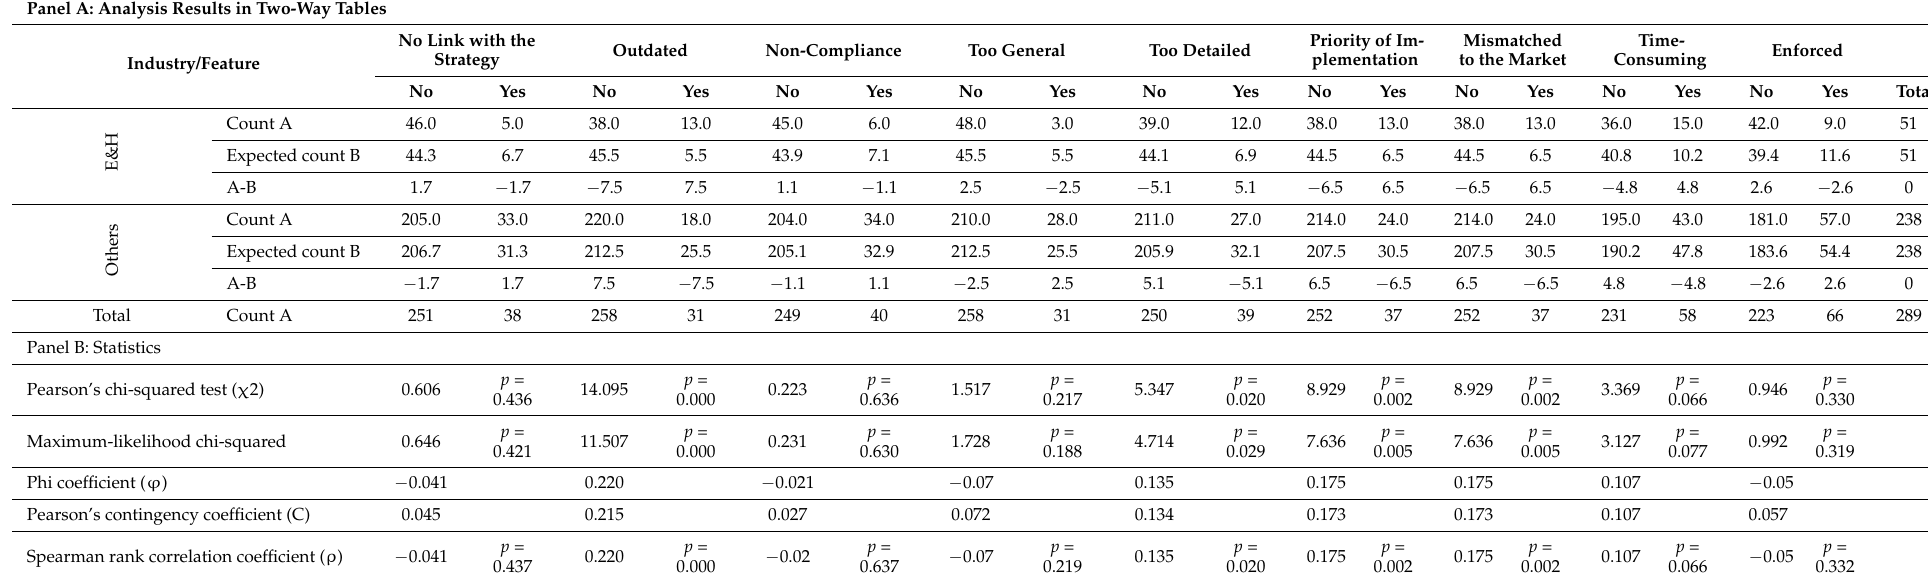
Table 11. Budgeting problems indicated by